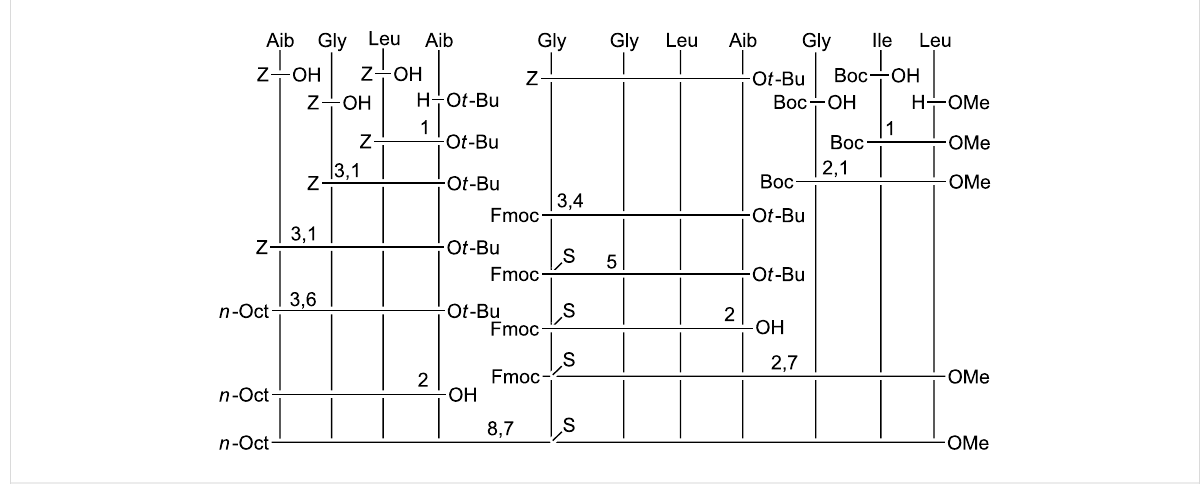
Scheme 2: Synthesis of ψ [CS-NH] 5 . 1: Coupling in the presence of EDC/HOBt. 2: Deprotection by using TFA/DCM. 3: Deprotection by catalytic hydrogenation with Pd/C. 4: Coupling with Fmoc-OSu in 1,4-dioxane. 5: Thionation with Lawesson's reagent in THF. 6: Coupling with n -Oct-OH in the presence of EDC/HOBt. 7: Coupling in the presence of EDC/HOAt. 8: Deprotection with DEA in DCM.